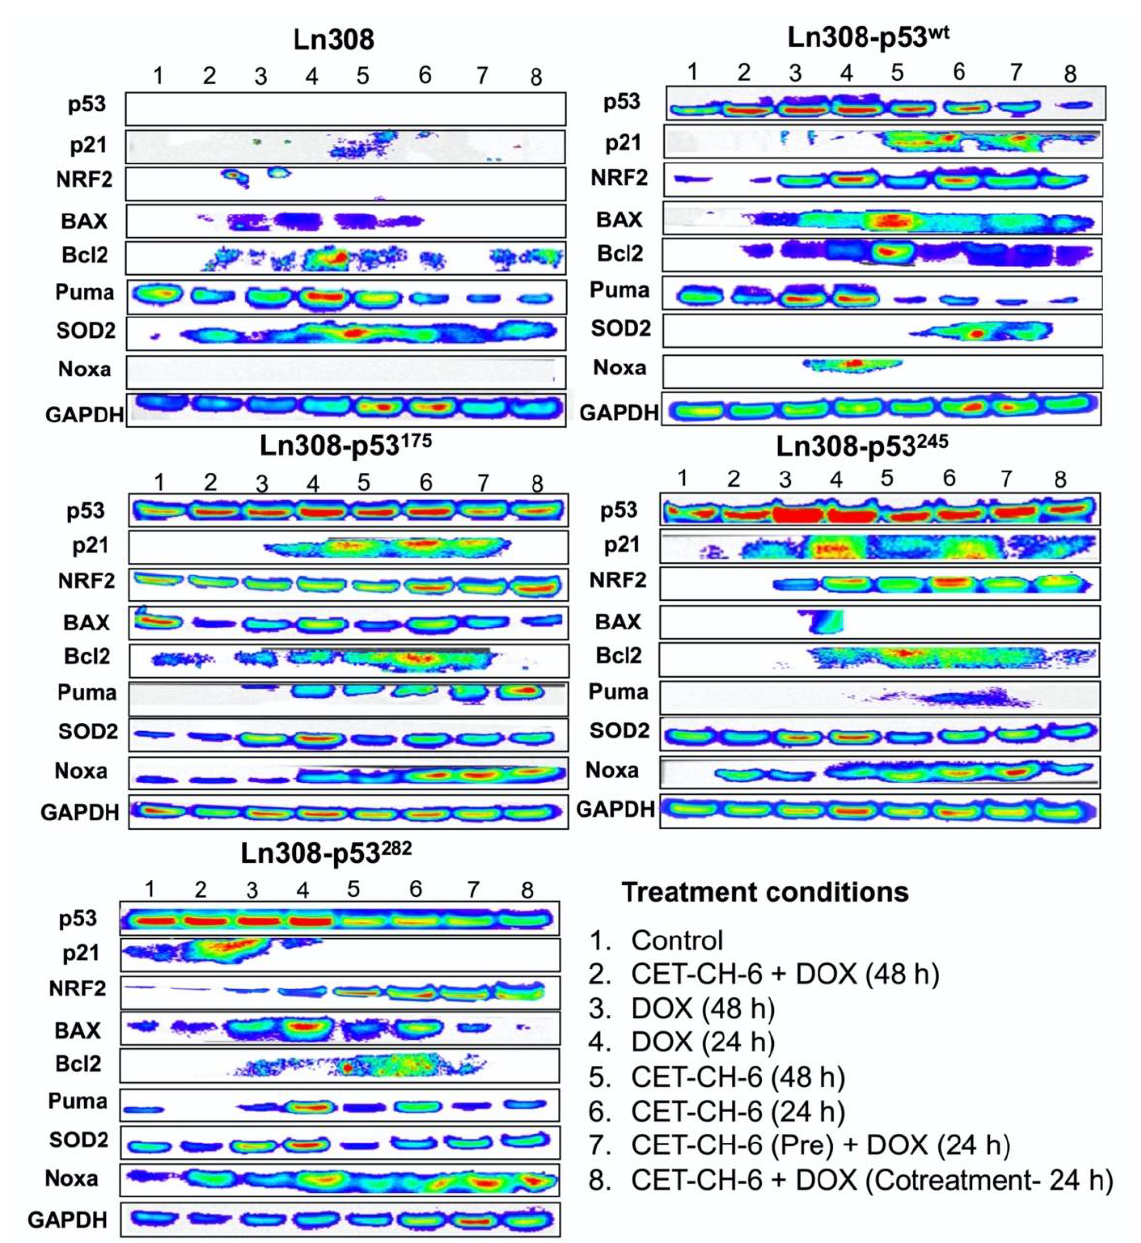
Figure 7. Genes in downstream pathway of p53 and Nrf2 are altered in response to treatment with CET-CH-6 and DOX. Treatment of LN308 cells stably expressing p53 variants (p53 wt , p53 175 , p53 245 , p53 282 ) activated expression of p53 responsive pathway proteins and the Nrf2 pathway. For representative whole Western blot membranes, please refer to Figure S10.